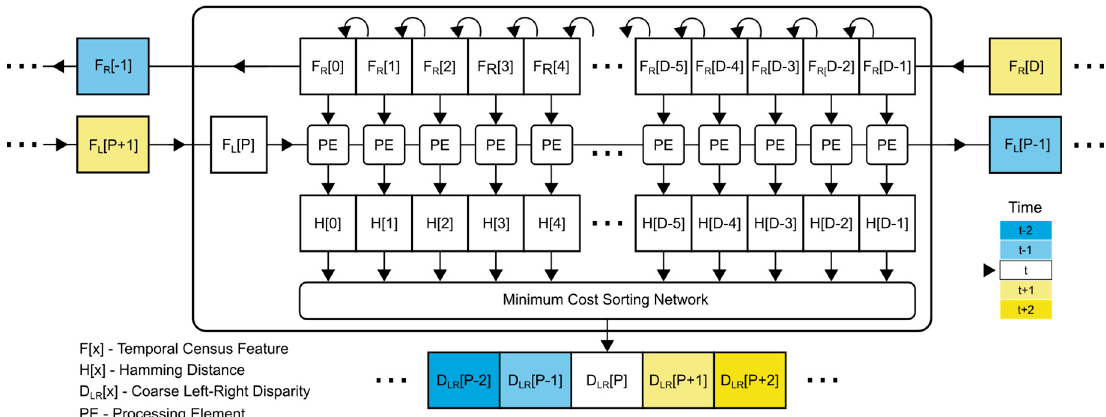
Figure 4. High-level overview of disparity calculation. The flow of data inside and into the design is displayed using arrows. Clock cycles are encoded, using different colors.